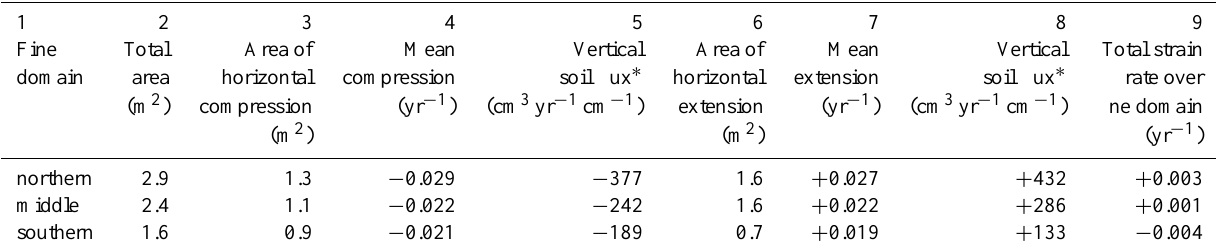
Table 1. Surface strain rates and areas on the three circles. Horizontal extension (divergence) at the surface is an indicator for upwards material transport ( + ), and vice versa ( − ).